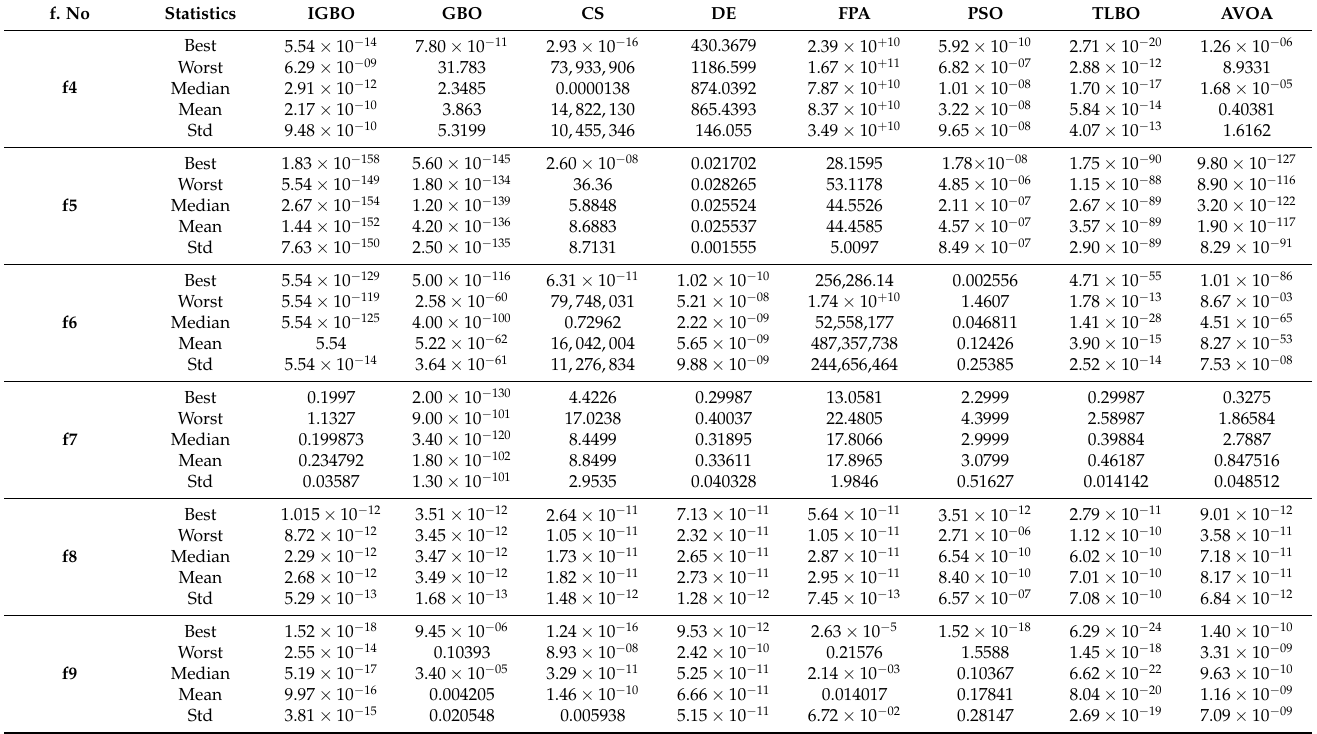
Figure 5. Friedman Mean rank test for unimodal functions. Multimodal benchmark functions are complicated tasks to test the exploration ability of the optimization algorithms to find the main optimal region of search domain. The results of IGBO for multimodal benchmark functions are compared with other algorithms in Table 6. Analysis of the results of this table shows that IGBO with its high exploration power, has provided the global optimal for (f4, f5, f6, f8), which indicates the more effective performance of IGBO. Table 6. Multimodal Benchmark Functions Results.